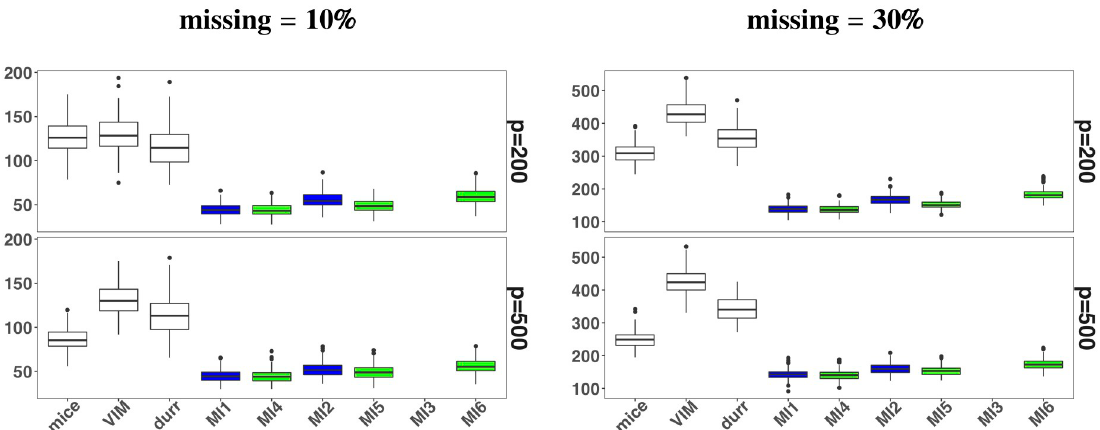
Fig 1. Simulation study: Box plots of MSIE. White boxes represent the threshold MI methods i.e., mice and VIM and durr . Blue and green boxes represent the MLE fit and ridge fit to the selected imputation model